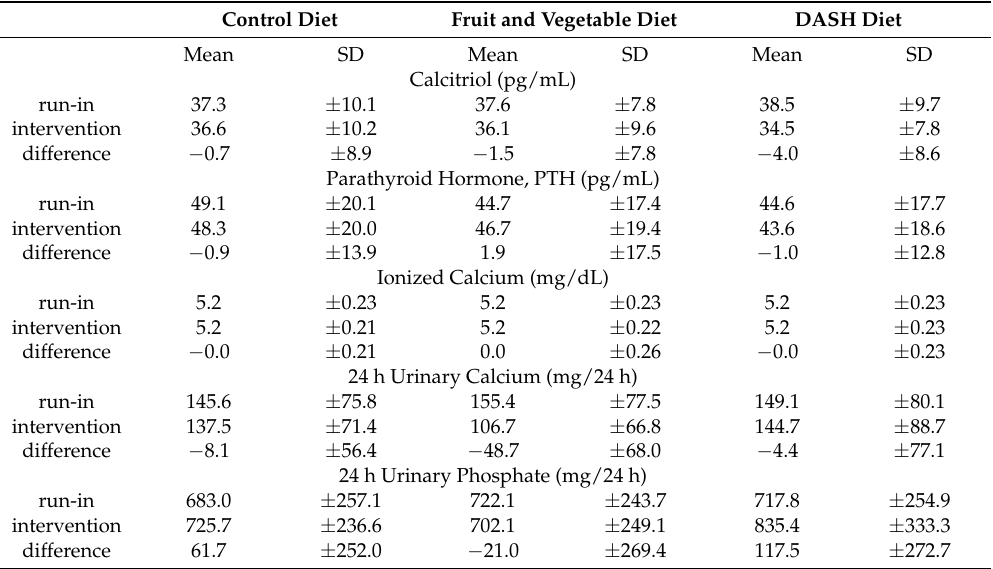
difference ± 272.7